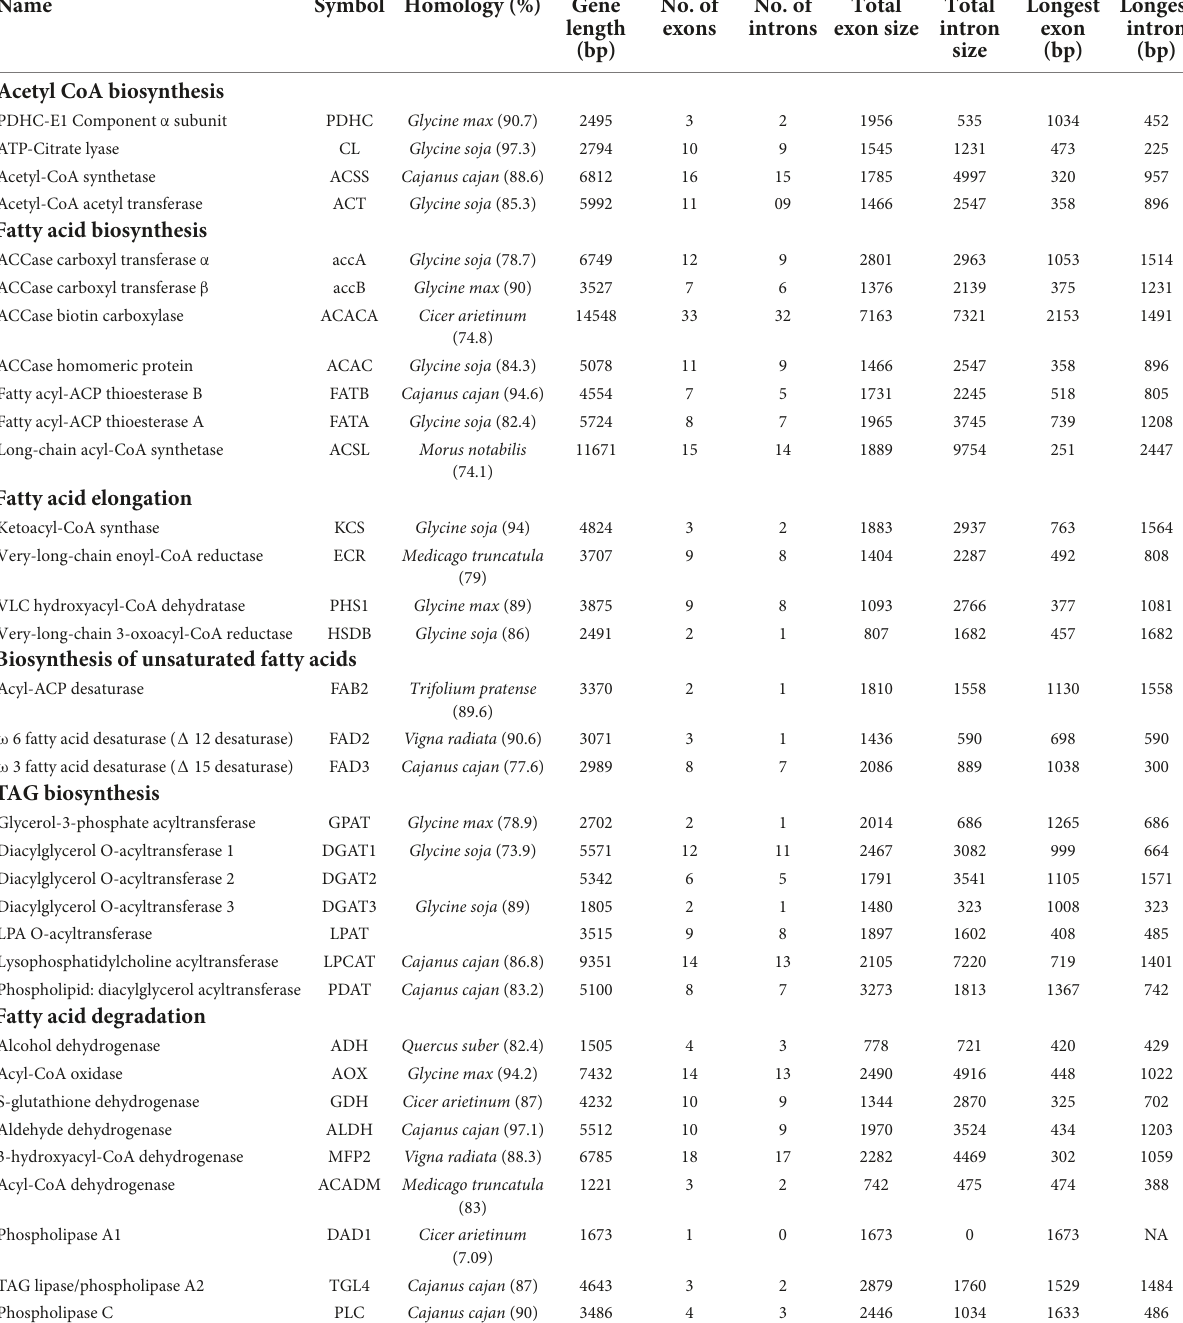
TABLE 5 Gene characteristics of key enzymes involved in lipid metabolism of